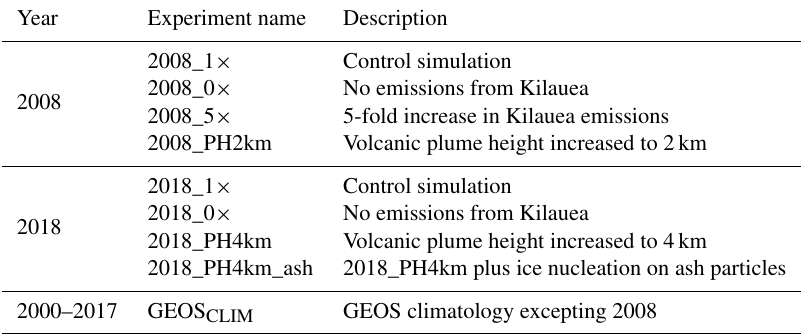
Table 2. Simulation experiments